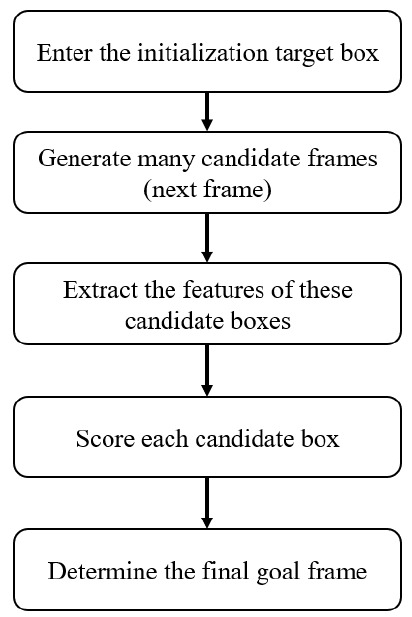
Figure 6. Basic structure and steps of STT system.